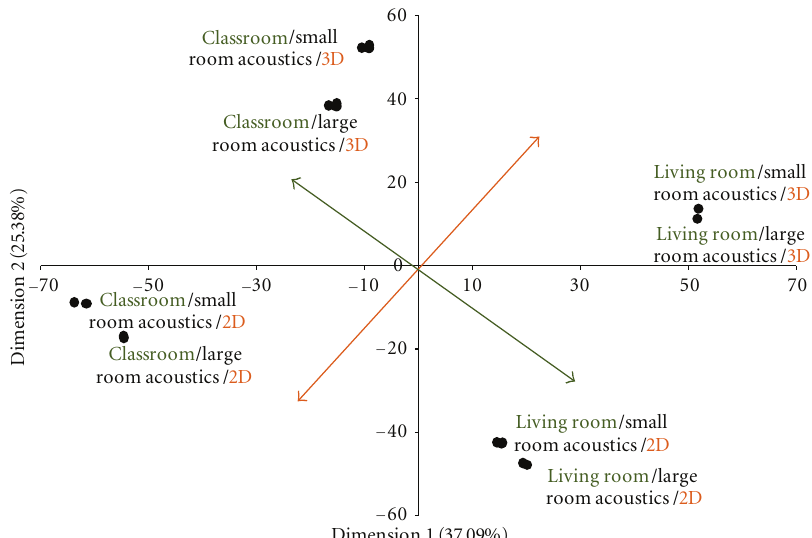
Figure 4: PC1-PC2 slice of the model showing test items plotted into the GPA model. The brown and green arrows clarify the dimensions of content (PC1) and video representation (PC2).